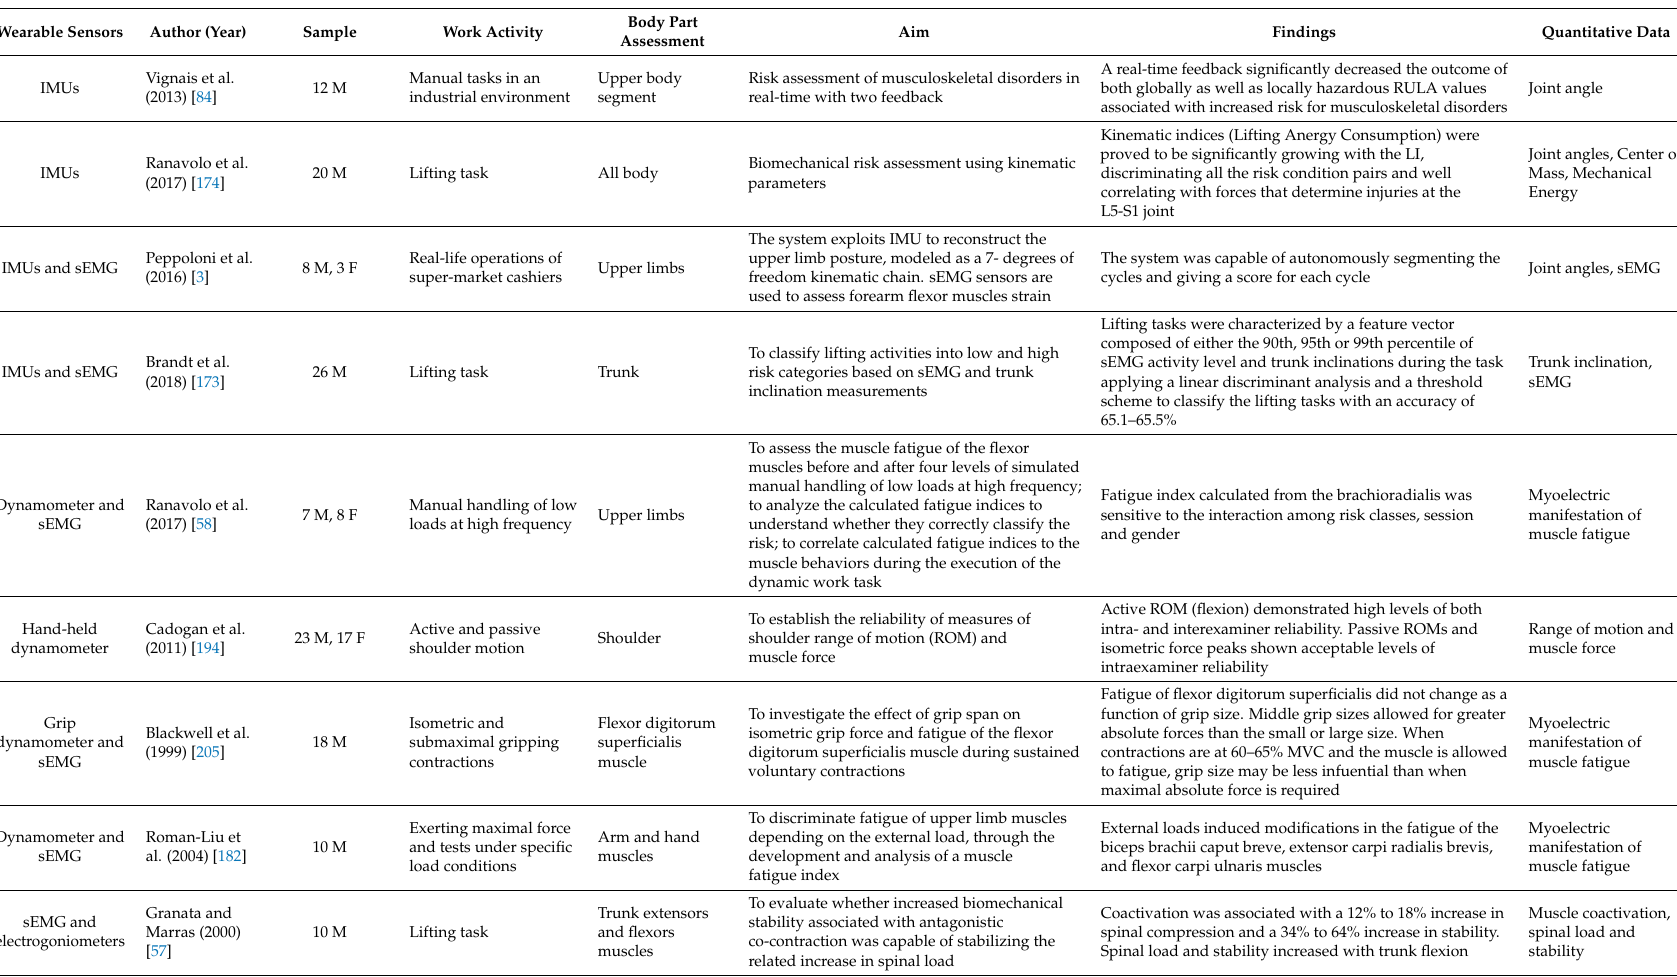
Table 1. Instrument-based techniques designed on current technological advances and performing direct measurements by using sensors attached to the workers body. M and F indicate male and female respectively. IMUs: inertial measurement units; sEMG: surface